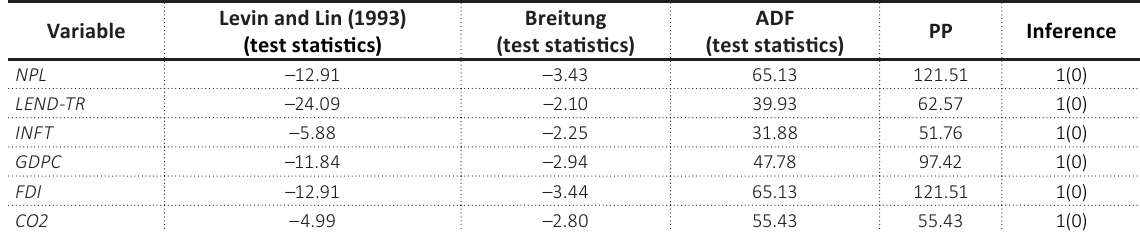
Table 3. Panel least square